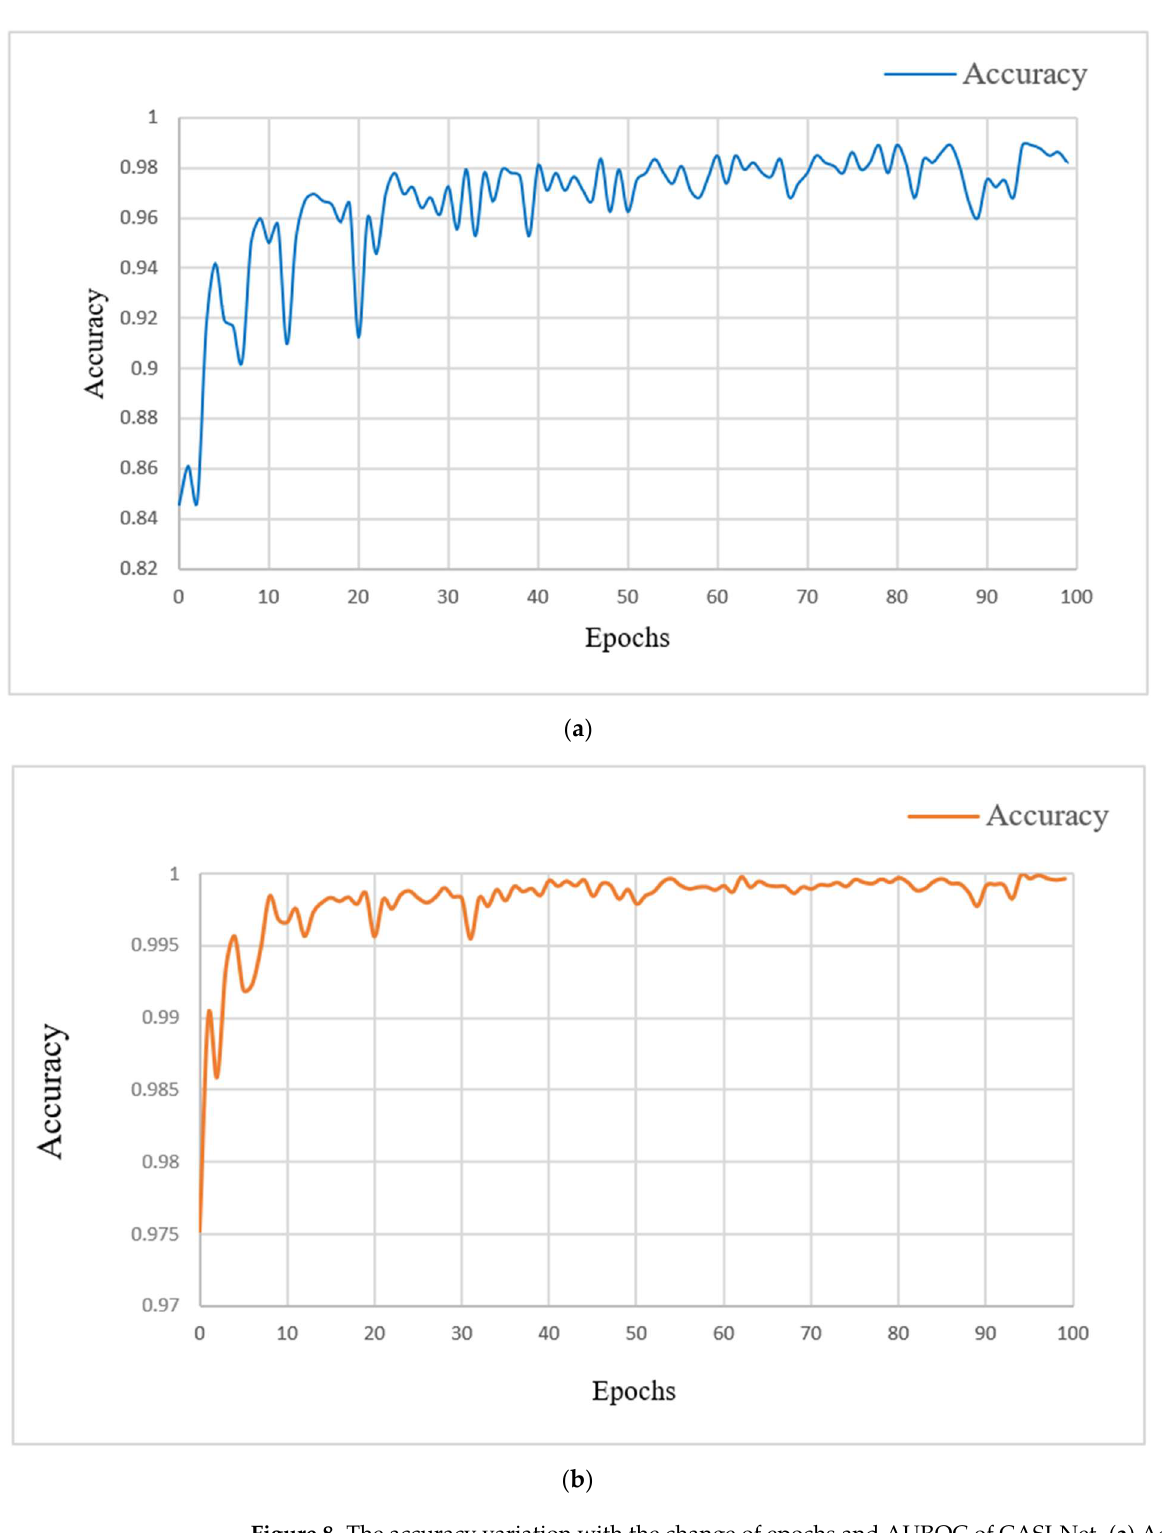
Figure 8. The a ccuracy variation with the change of epochs and AUROC of CASI-Net. ( a ) Figure 8. The accuracy variation with the change of epochs and AUROC of CASI-Net. ( a ) Accuracy Accuracy variation with the change of epochs; ( b ) AUROC. variation with the change of epochs; ( b )